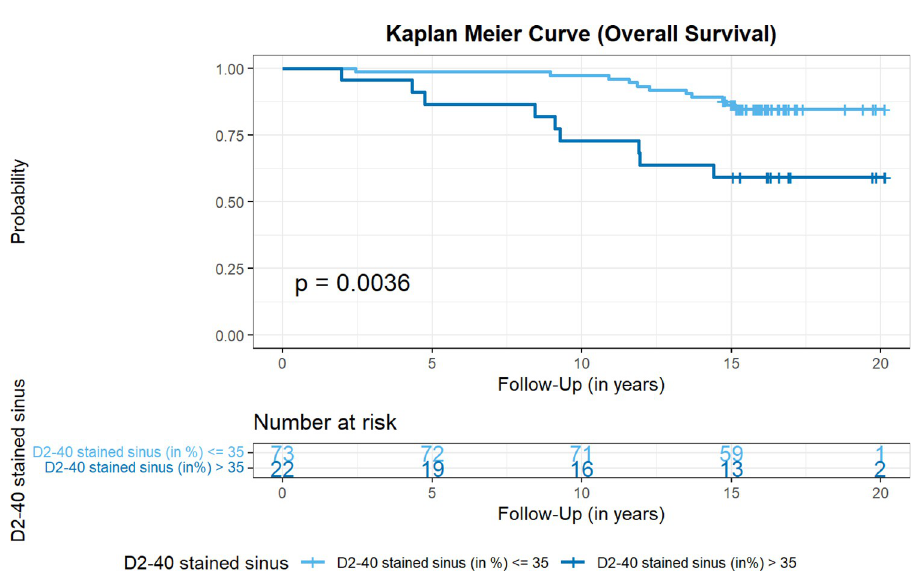
Fig 6. Kaplan-Meier curve for overall survival with respect to the proportion of D2-40-positive stained sinus in SLN. According to the optimal cutoff point determined by the Cutoff Finder algorithm, overall survival was plotted for the proportion of D2-40 positive stained subcapsular sinus in sentinel lymph nodes. Overall survival was significantly longer for patients with � 35% stained sinus, p value of the logrank test.